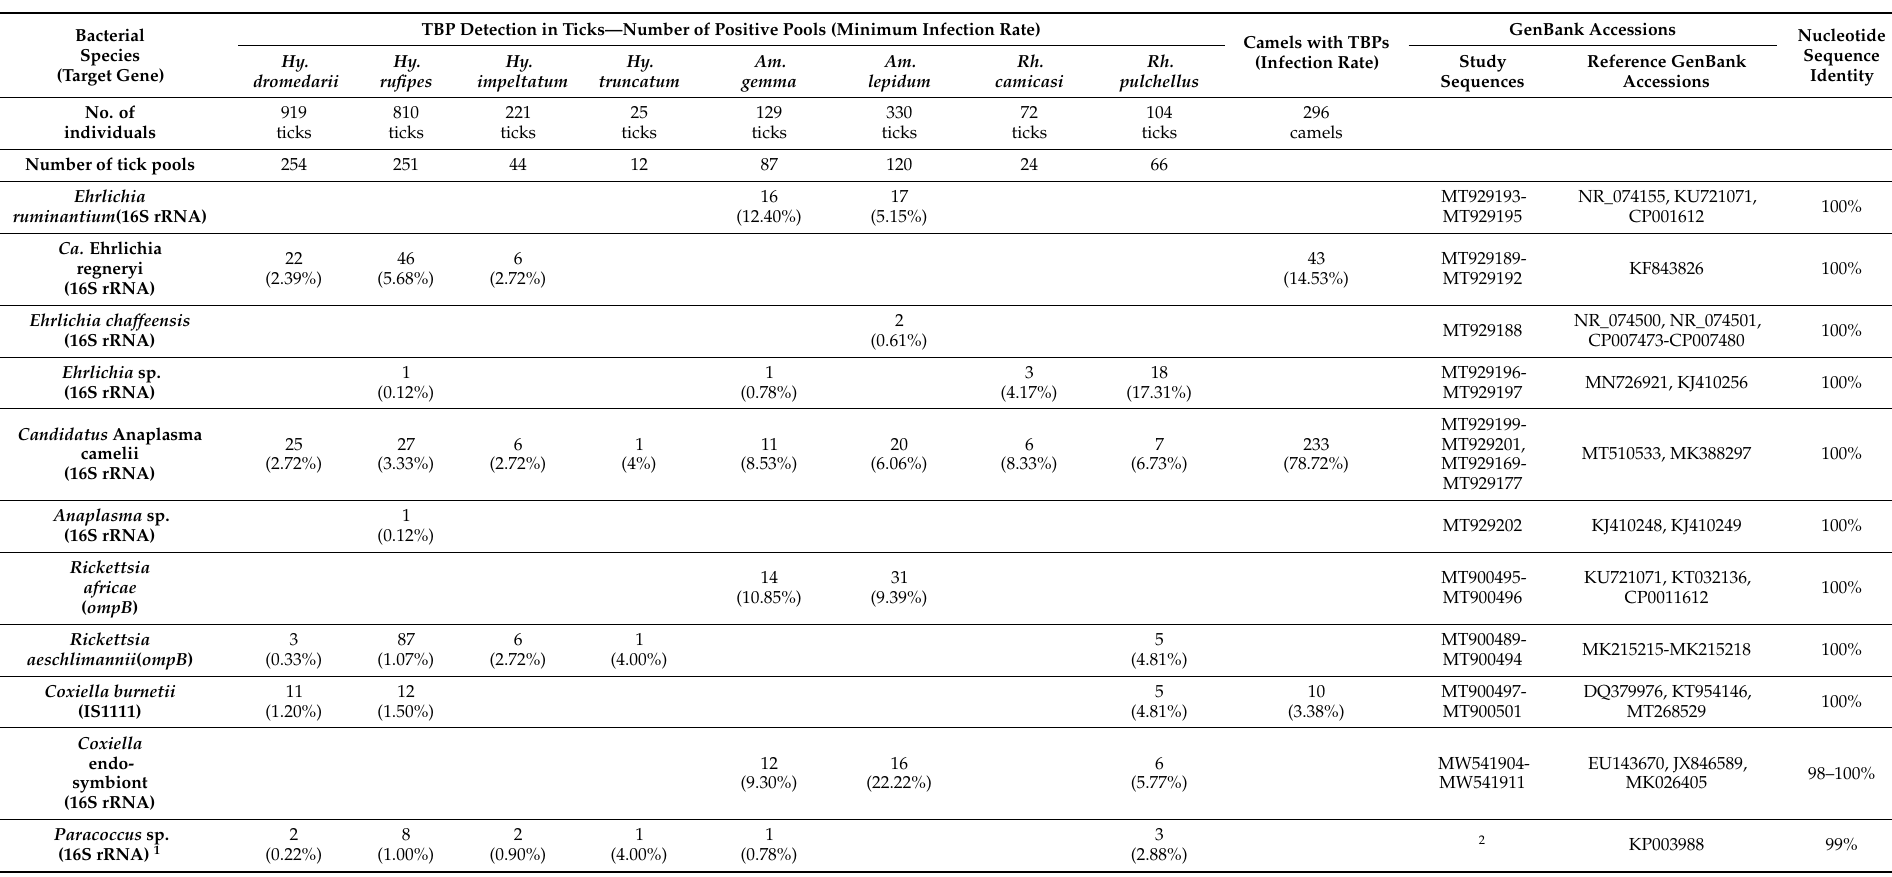
Table 3. Minimum infection rates for tick-borne pathogens (TBPs) identified in ticks and blood samples collected from camels in Marsabit, Kenya (February 2020 to March 2020). Bacterial